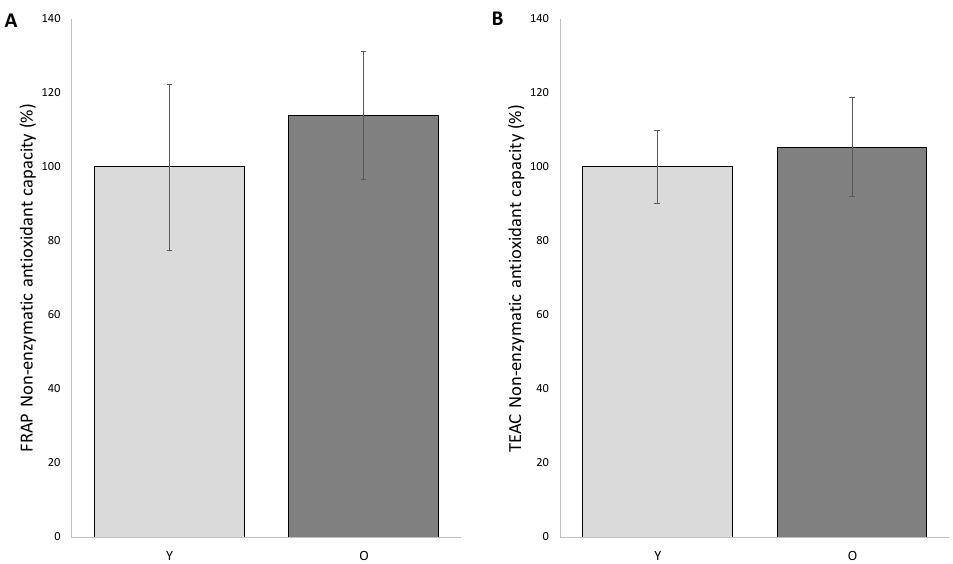
Figure 1. Total non-enzymatic antioxidant capacity of follicular fluids from young (Y) and old (O) women measured by means of ferric reducing / antioxidant power (FRAP) ( A ) and TEAC-ASBT ( B ). Values are expressed as % as respect to control (group Y), considered to be 100%. The values are the mean of three determinations ± SD. Biochemical analysis was carried out in duplicate in each biological sample.